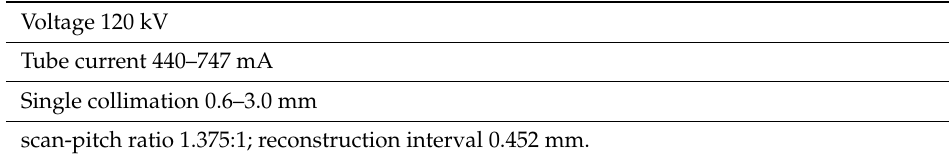
Table 1. The scanning parameters of the